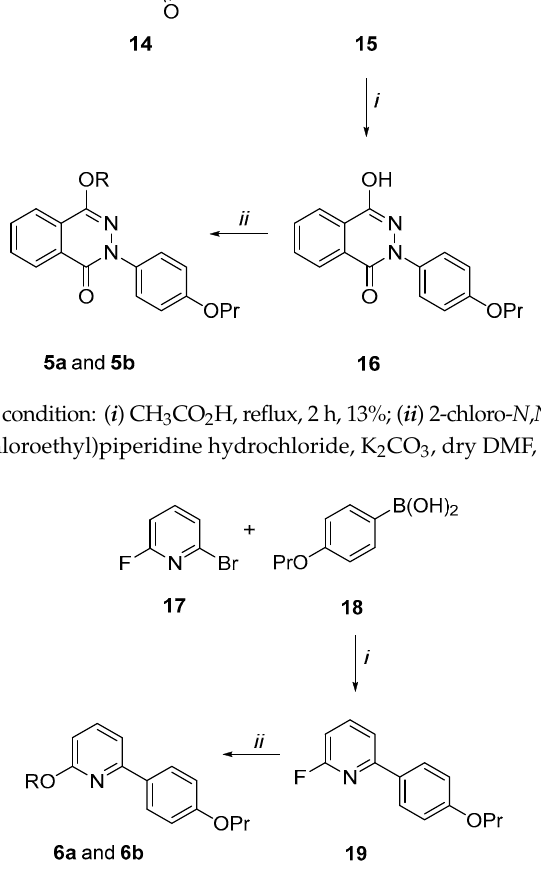
Table 1. MIC values (µg/mL) of derivatives 3a , 3b , 4a , 4b , 5a , 5b , 6a , 6b , the starting hit 1 and CPX against SA-1199 and